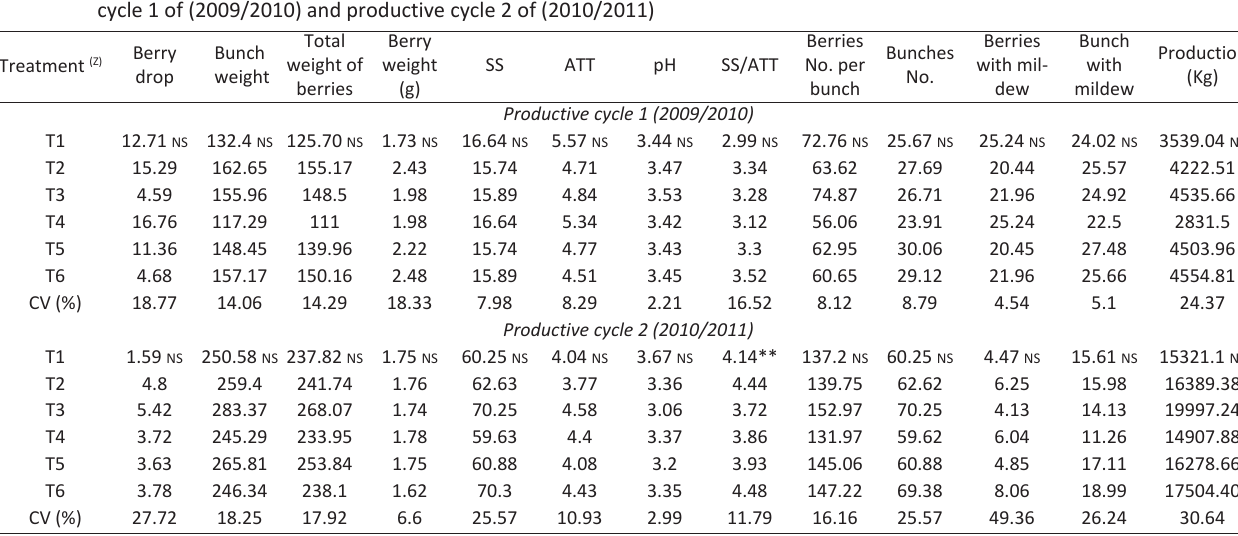
Fig. 1 - Data obtained from INMET’s meteorological station, from productive cycle 1 (2009/2010) (A) and productive cycle 2 (2010/2011), located at Universidade Tecnológica Federal do Paraná - campus Dois Vizinhos - PR. Table 1 - Berry drop (%), bunch weight (g), weight of total and individual berries (g), SS (°Brix), ATT (g of tartaric acid 100 mL -1 ), pH, SS/TTA ratio, number of berries per bunch, number of bunches, rot berries and bunches (%), production per plant (Kg) of Merlot grapes submitted or not to management practices with or without the use of reflexive films on the soil, in productive cycle 1 of (2009/2010) and productive cycle 2 of (2010/2011)